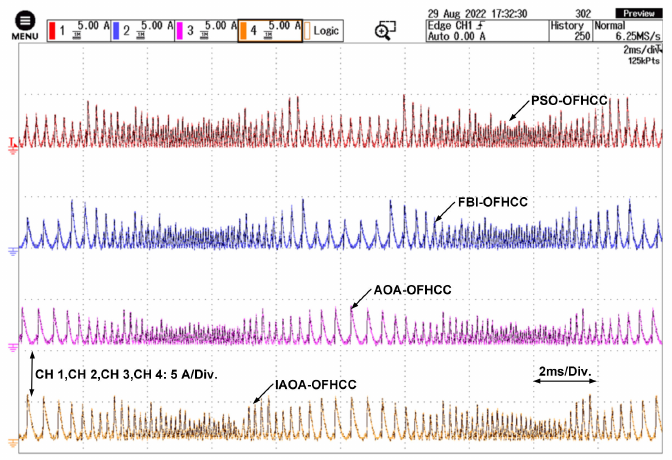
Figure 19. Experimental results showing current error for PSO-CHCC, FBI-CHCC, AOA-CHCC, and IAOA-CHCC.